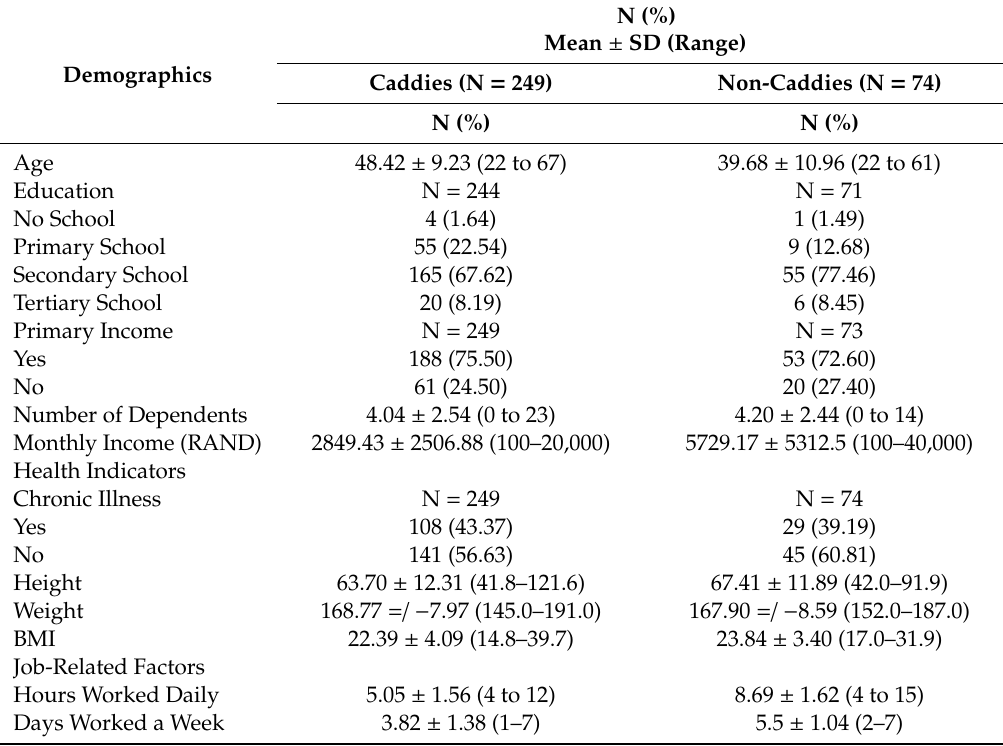
Table 1. Socio-demographic and past history of disease distribution according to caddying and non-caddying group of male